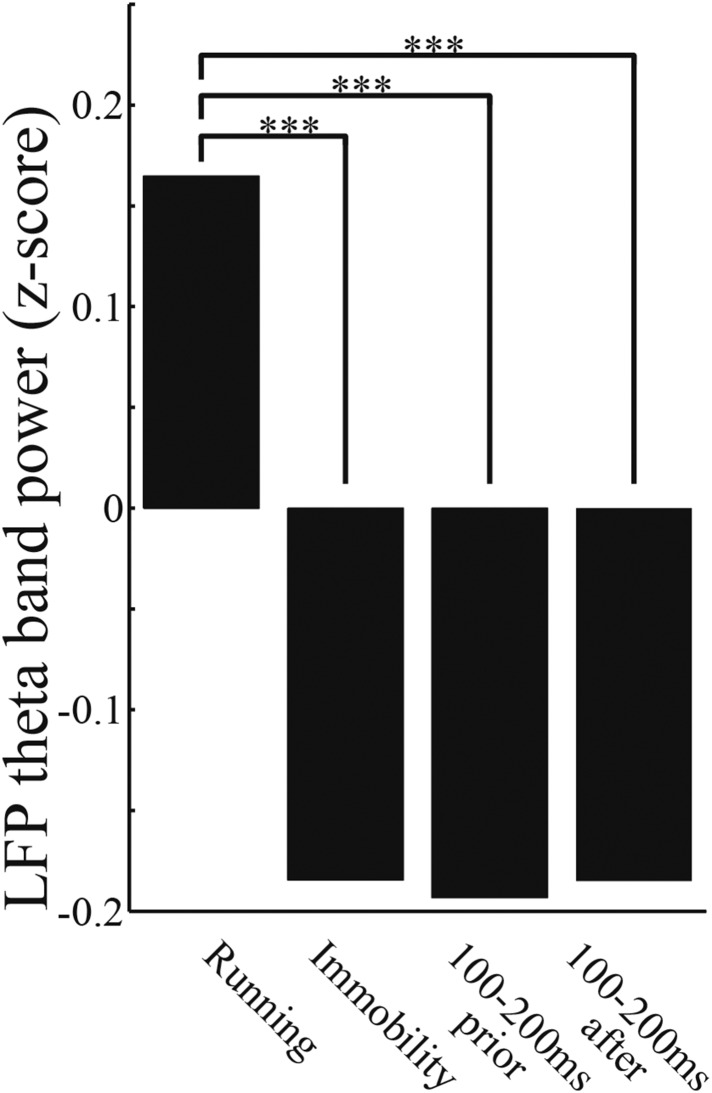
LFP theta power decrease in the replay.The average LFP power in the theta band (4–12 Hz) during running (speed > 5 cm/s), and immobility (speed < 2 cm/s), and for 100–200 ms immediately before and after each replay throughout the entire session. (Kruskal–Wallis test, Tukey's post hoc multiple-comparison; ***: p < 0.0001).